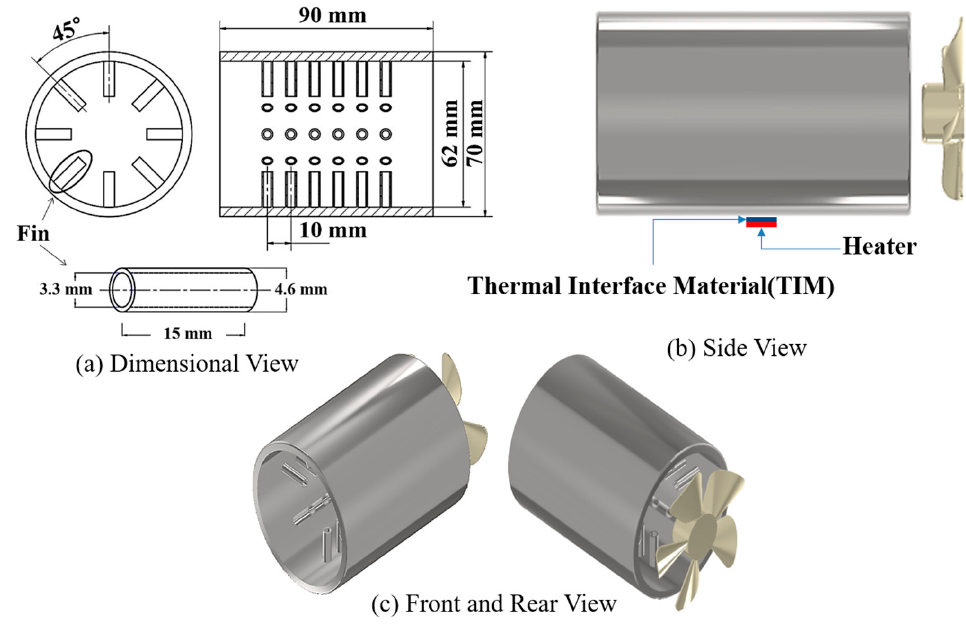
Figure 2. The design and shape of the CAHP. A screen mesh wick (2-layered, 500 mesh, Stainless Steel 304) was installed in the internal outer surface, and the thickness of the wick was 0.34 mm. The material of the container was stainless steel 304, and the thickness of the tubes is 0.4 mm. The thermal properties of the CAHP are shown in Table